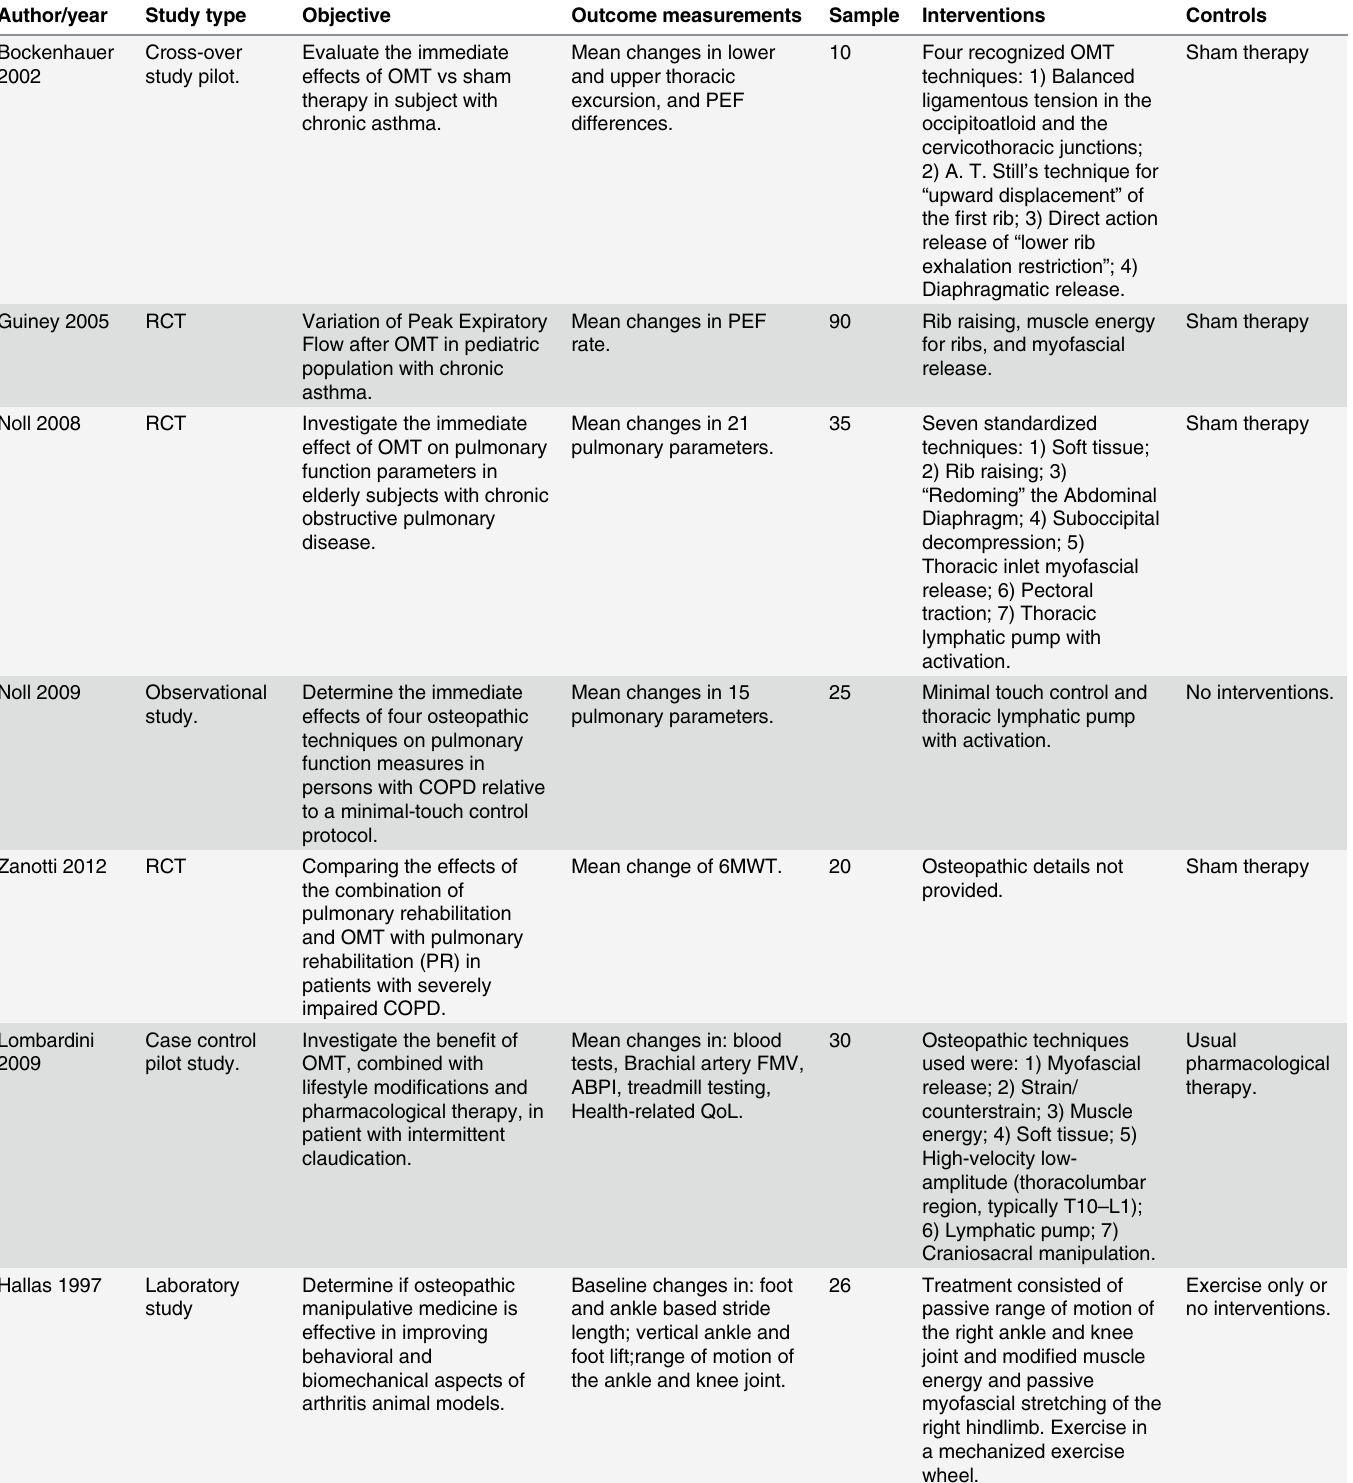
Table 1. Overview of included studies of osteopathic manipulative treatment for chronic inflammatory